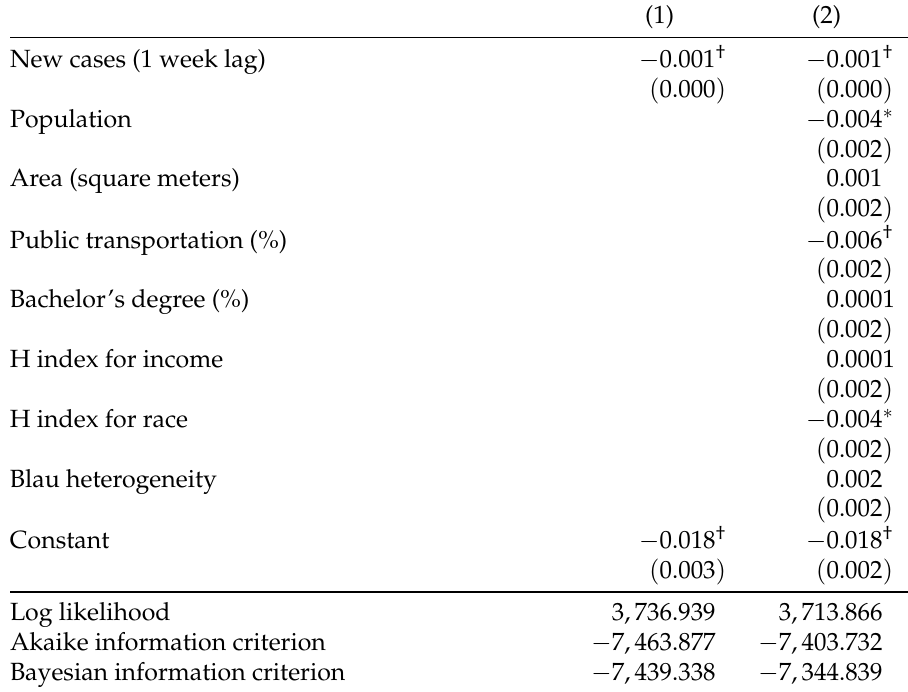
Table 2: Mixed effects models of relative equitable mobility